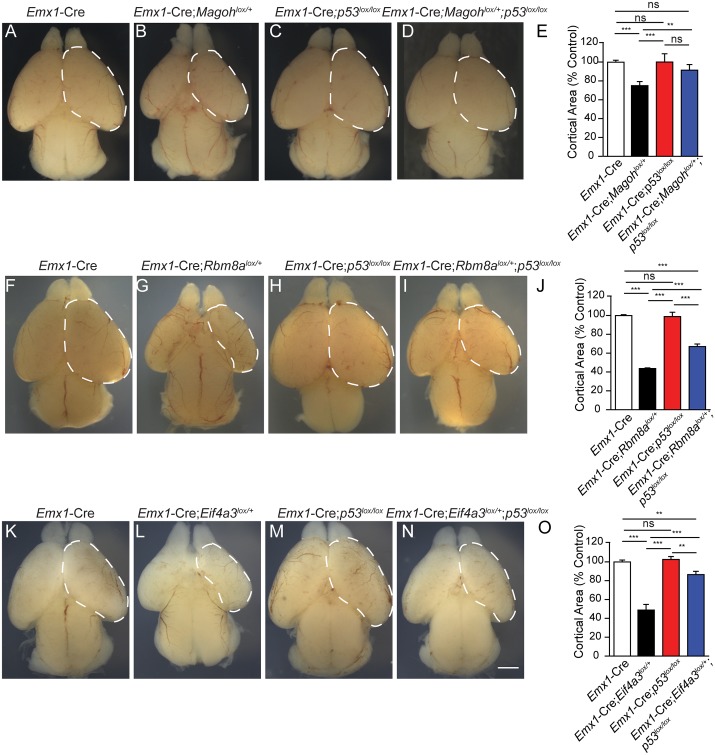
Loss of p53 partially rescues microcephaly of Magoh, Rbm8a, and Eif4a3 haploinsufficient mutants.(A-D, F-I, and K-N) Whole mount brains of E18.5 embryos with indicated genotypes. (E, J, O) Quantification of cortical area in E18.5 embryonic brains with indicated genotypes. Dotted lines demarcate the dorsal cortical areas measured. The surface area of littermate control brains was set to 100. ANOVA with Tukey posthoc, **, p<0.01, ***, p<0.001, NS, not significant. Error bars, S.D. n = 3–9 biological replicates each. Scale bars, A-D, E-I, and K-N, 1 mm.